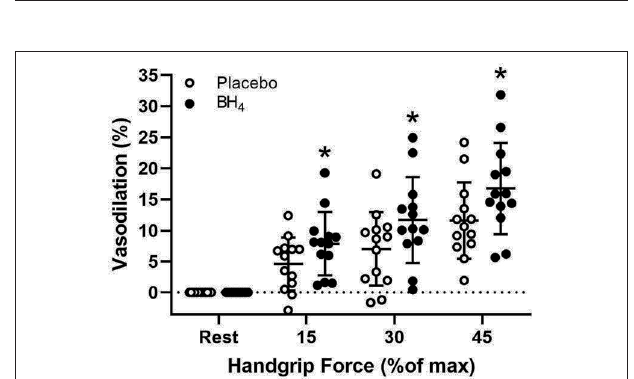
FIGURE 3 | Brachial artery vasodilation during progressive handgrip exercise in patients with systemic sclerosis after placebo (white circles) and tetrahydrobiopterin (BH 4 ; black circles). * P < 0.05, significantly different than placebo. All data are presented as mean ± SD.